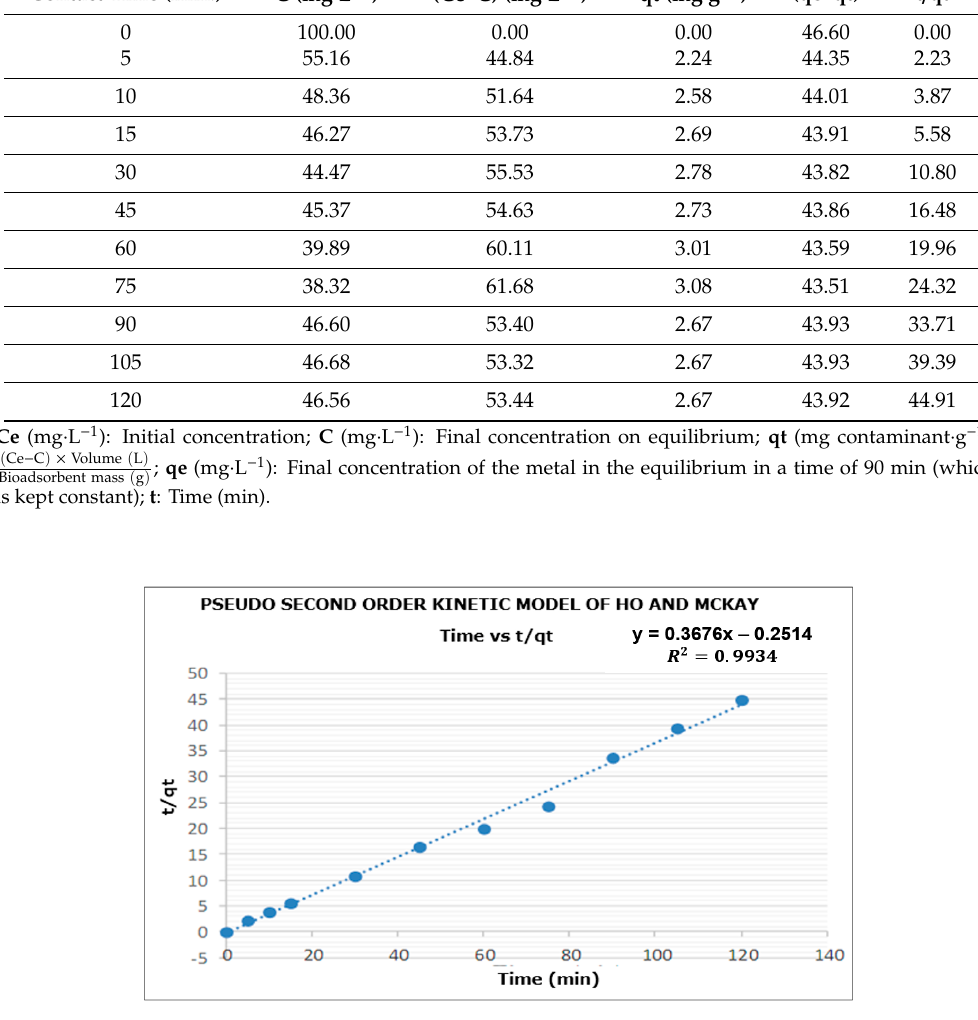
Table 3. Experimental results in the determination of the kinetic model with di ff erent contact times of the Mn (II) removal process with CP. Contact Time (min.)